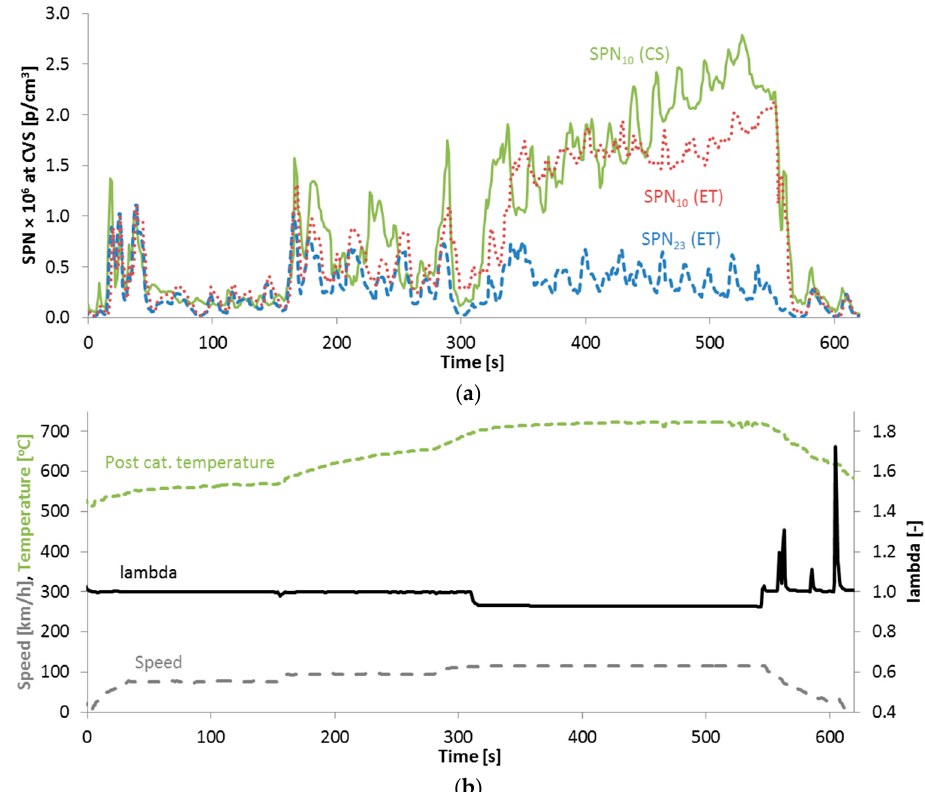
Figure 8. ( a ) Lambda; ( b ) solid particle number (SPN) emissions > 23 nm and > 10 nm measured at the tailpipe for L3e-A3 #8. Percentages give the additional particles < 23 nm. Speed and exhaust gas temperature are also shown.